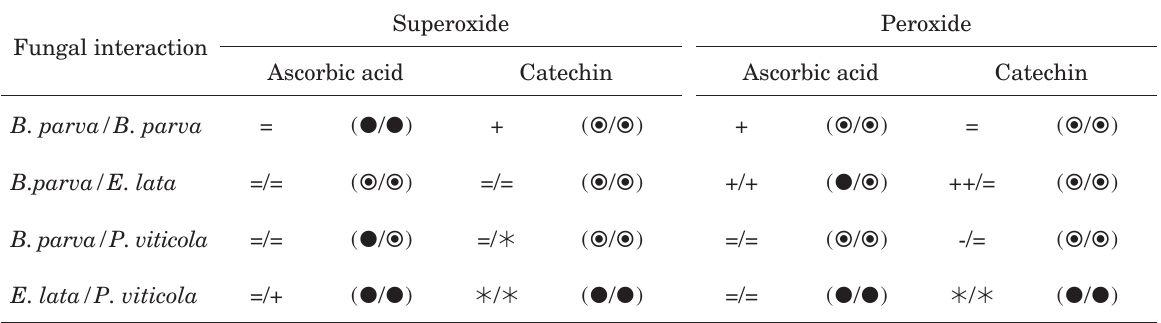
1. Fungal interactions in Czapek Dox solid medium with 2.5 mg ml-1 of antioxidant supplement (ascorbic